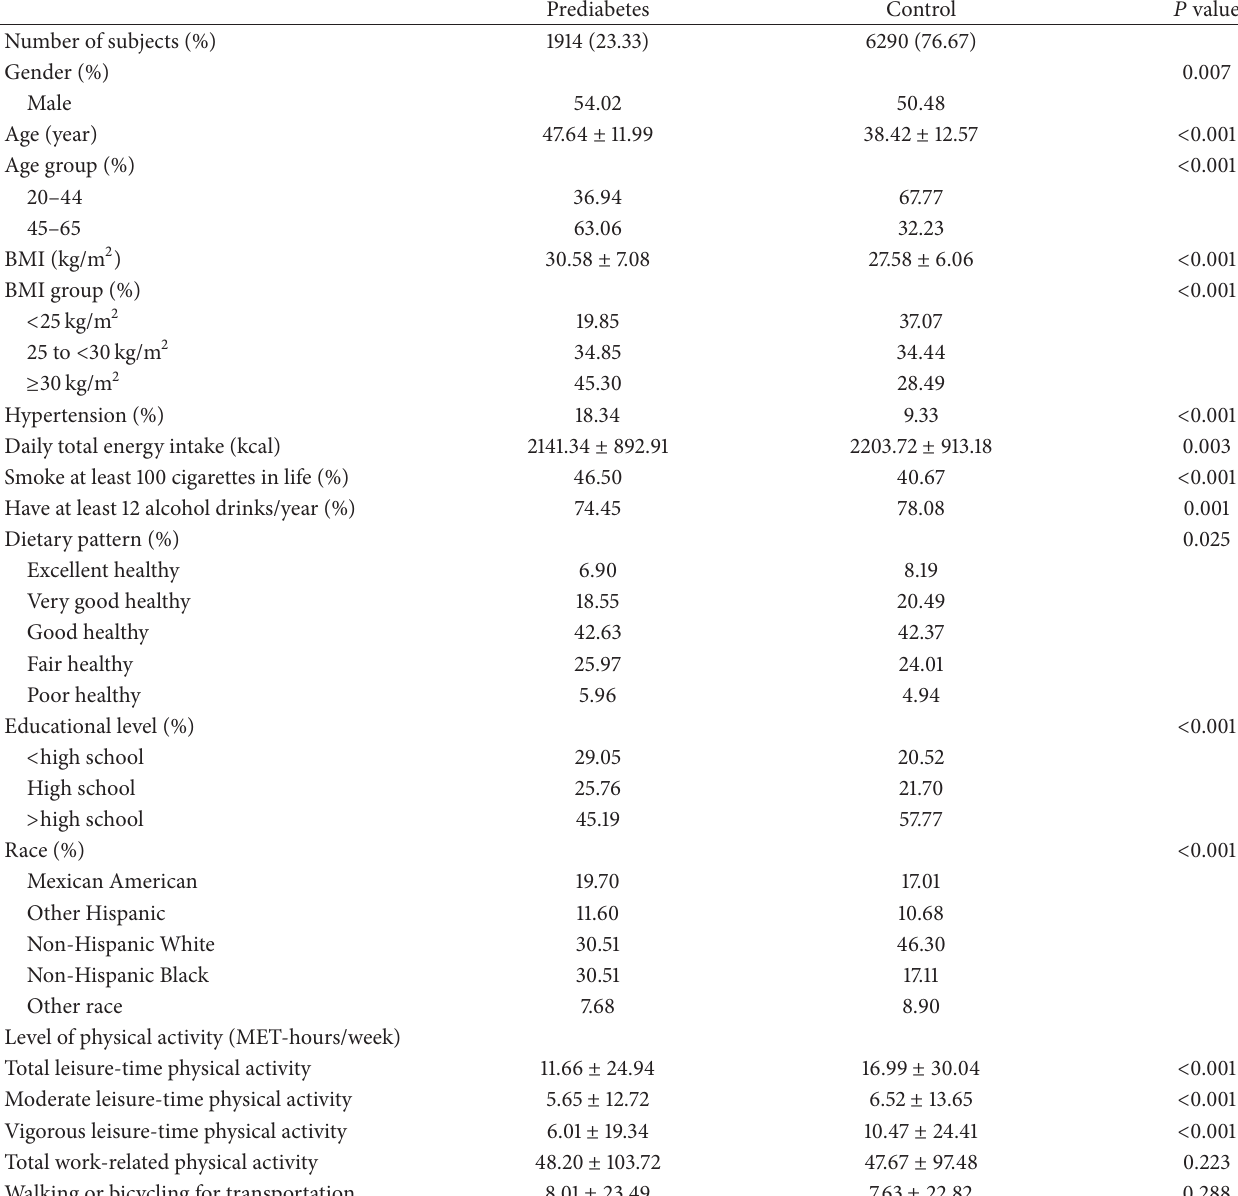
Table 1: Characteristics of participants by prediabetes status, NHANES 2007–2012, ages 20–65